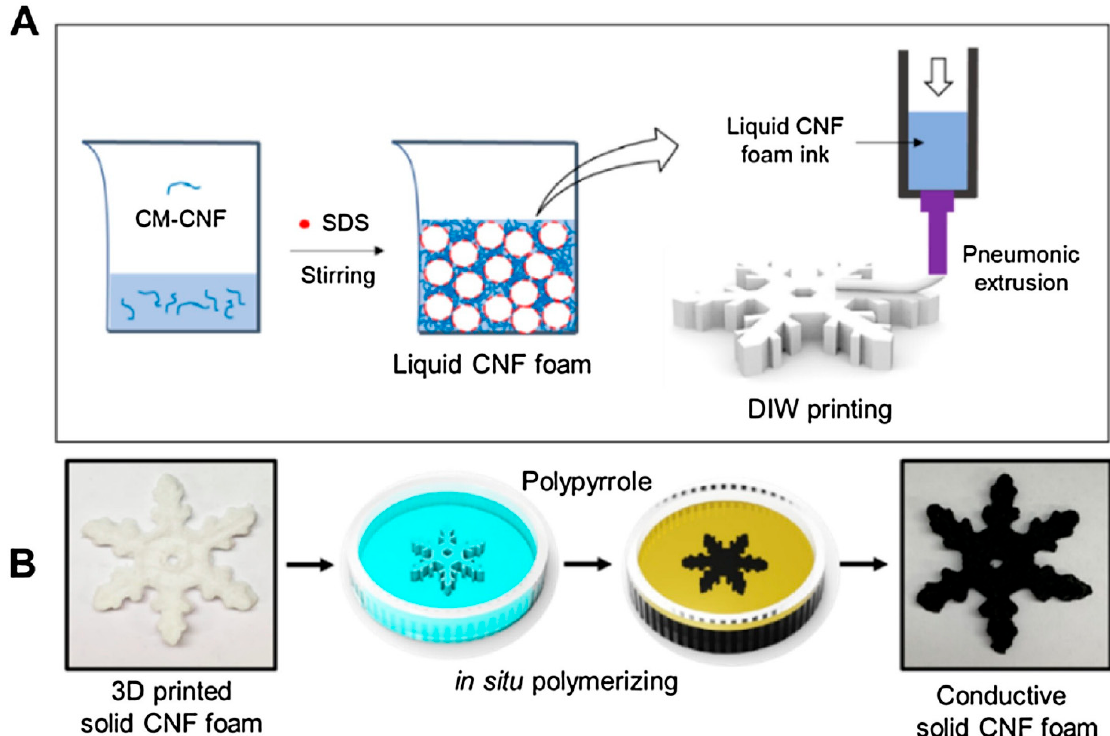
Figure 4. Procedure to prepare conductive solid cellulose nanofiber (CNF) foam-based 3-D materials [80]. ( A ) The liquid CNF foam ink is generated by stirring carboxymethylated (CM)-CNF suspension using sodium dodecyl sulfate (SDS) as an emulsifier to induce phase separation; ( B ) conductive foams are prepared through in situ polymerization of polypyrrole (PPy) on solid CNF foams. Adapted with permission from Elsevier, 2021. Molecules 2021 , 26 , x FOR PEER REVIEW